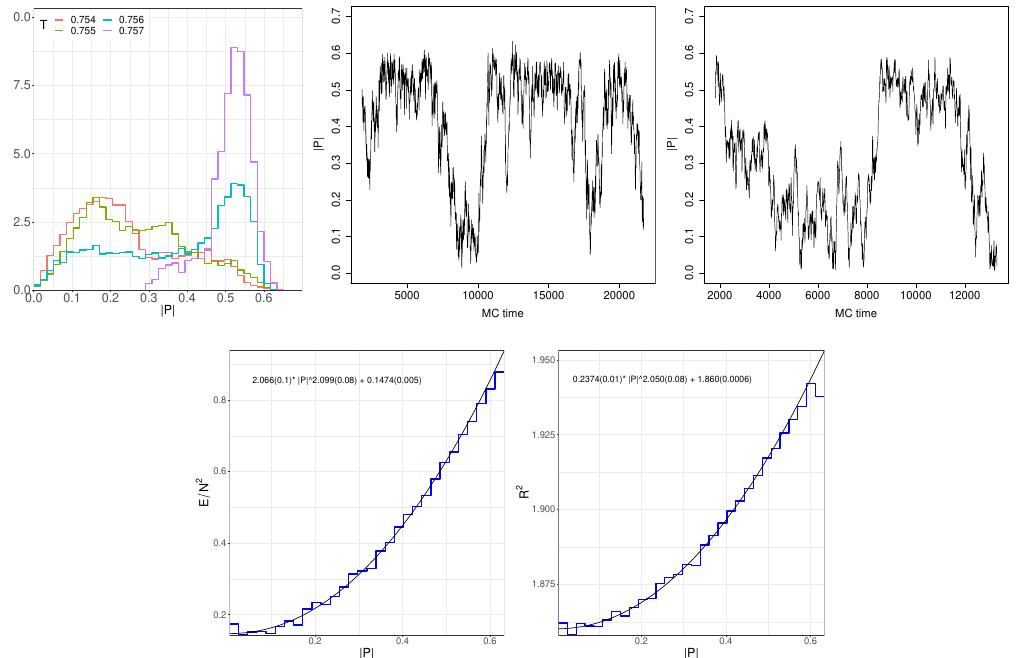
Figure 14. Full BMN model, flux µ = 3 . 0 , matrix size N = 32 , lattice size L = 12 at temperature T = 0 . 756 . [Top] From left to right, histogram of | P | close to the critical temperature, and Monte Carlo history for the Polyakov loop at the same parameters for two typical runs with different sequences of random numbers. A two-state signal is observed. [Bottom] Binned E vs | P | and binned R 2 vs | P | . Larger values of | P | (more deconfined) corresponds to larger values of E and R 2 , as